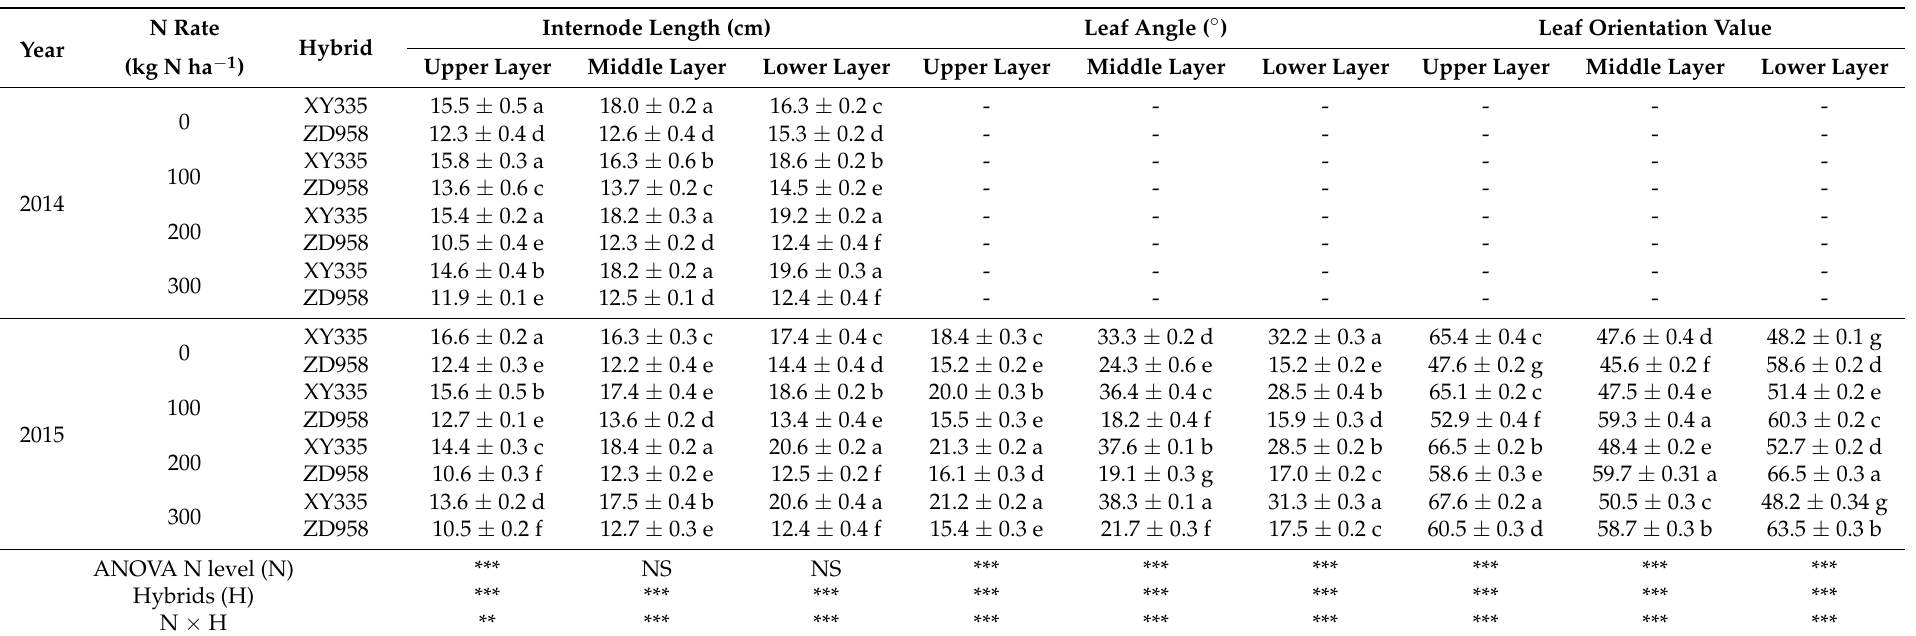
Table 2. Internode length, leaf angle, and leaf orientation of different maize genotypes under high plant